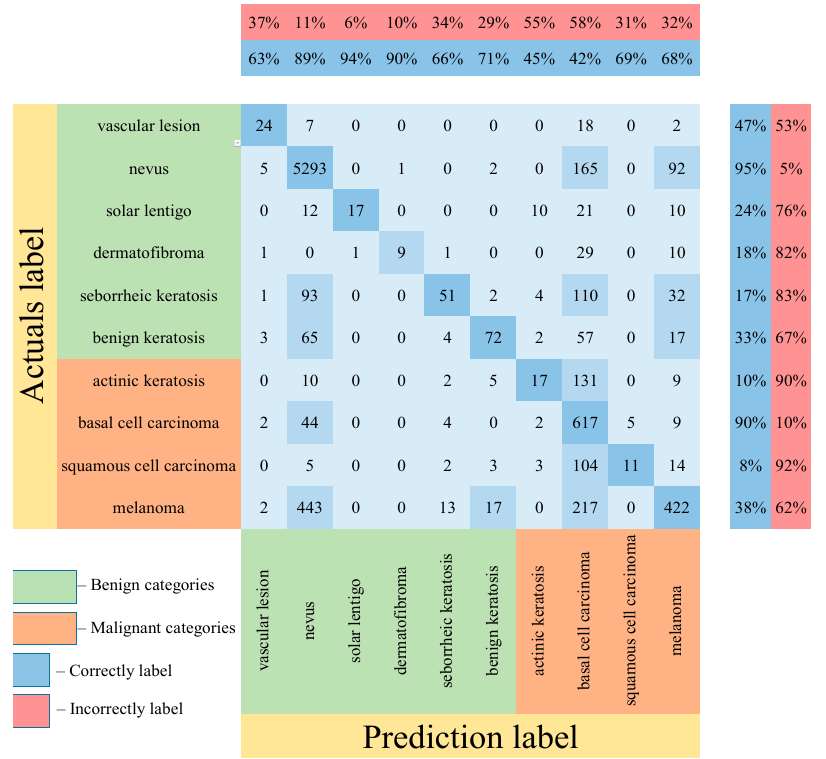
Figure 14. Confusion matrix in the testing results in a multimodal neural network system for recognizing pigmented skin lesions based on CNN SqueezeNet.